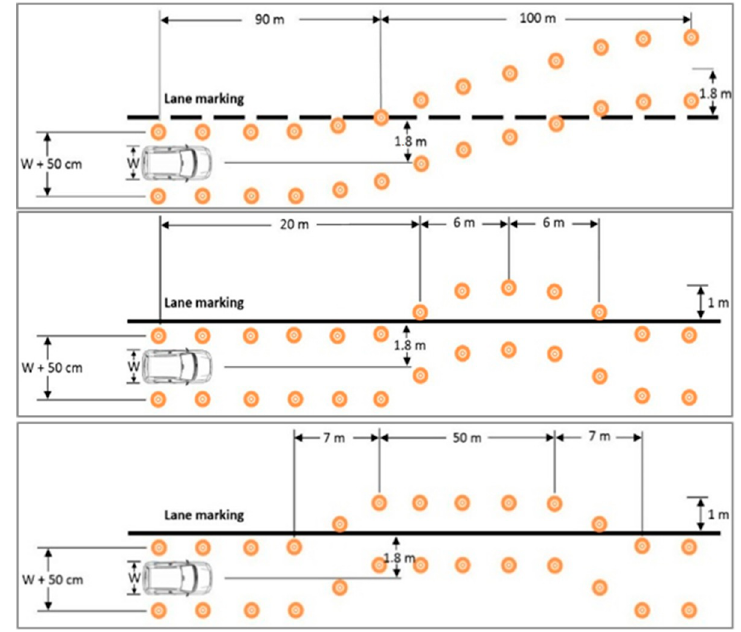
Figure 3. Specifications of three maneuvers.